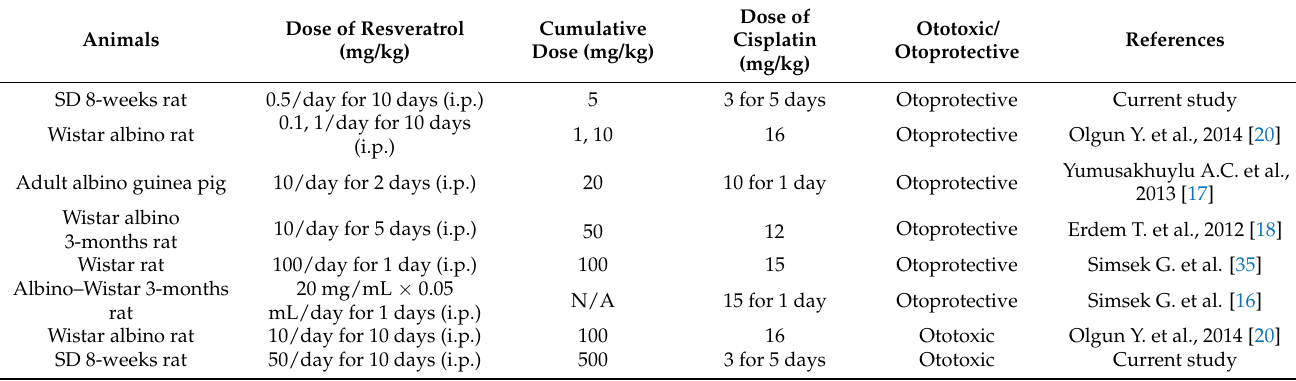
Table 1. Studies on the effects of resveratrol on the cisplatin-induced ototoxicity. i.p., intraperitoneal injection; N/A means not